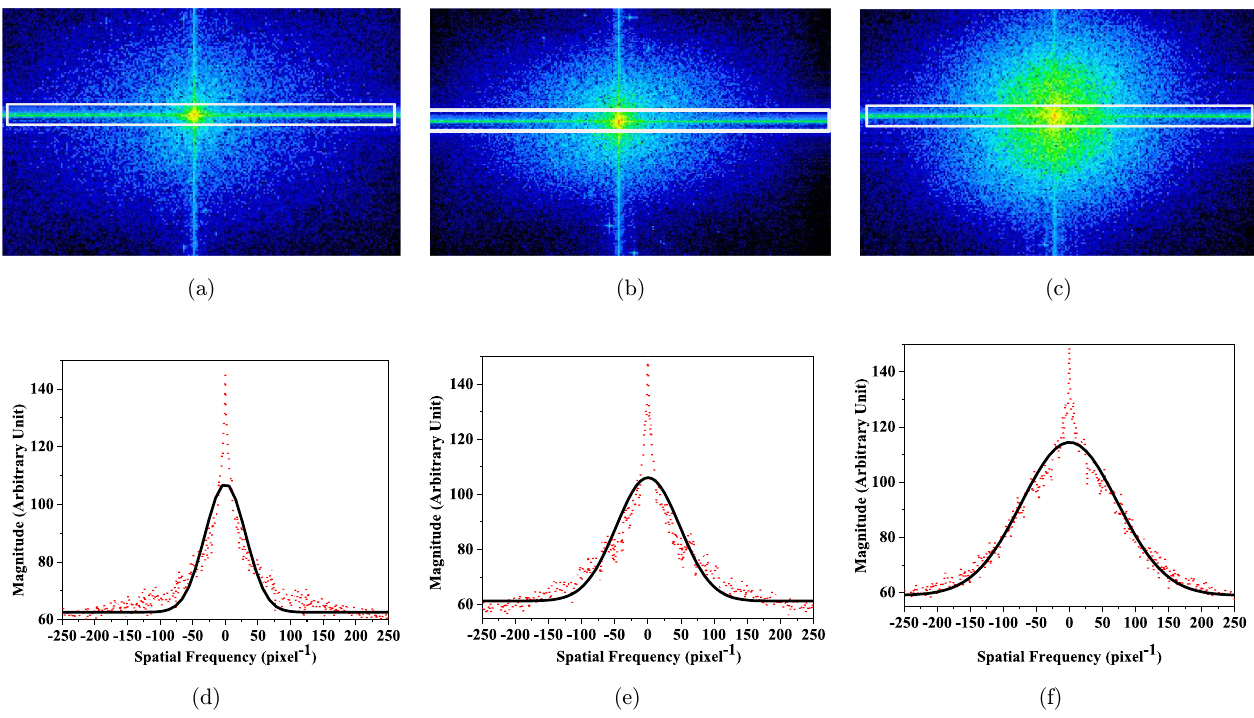
Fig. 2. (a) – (c) are 2D spatial frequency spectra obtained from their corresponding confocal microscope images shown in Figs. 1(a) – 1(c), respectively; (b) – (d) are 1D spatial frequency spectra (dot line) along the horizontal direction through the peaks of the 2D spectra in (a) – (c), respectively, along with their corresponding ¯tted Gaussian distributions (solid